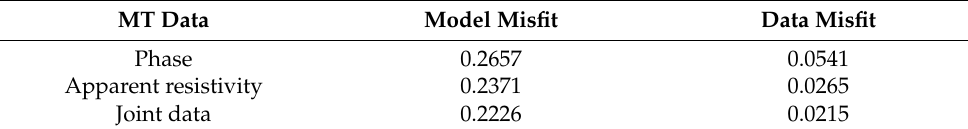
Table 5. Mean model and data misfits of the test set for the apparent resistivity, phase and joint data.